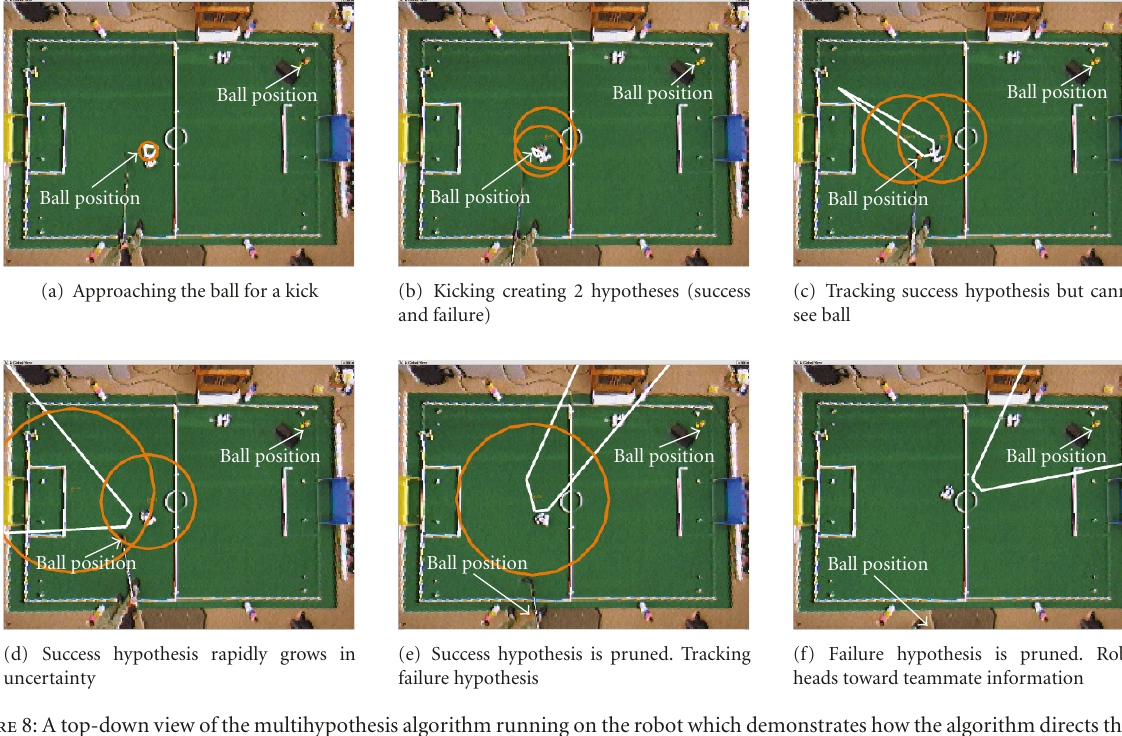
Figure 8: A top-down view of the multihypothesis algorithm running on the robot which demonstrates how the algorithm directs the robot’s actions. The field of view of the robot’s camera is shown with white lines while the circles represent the uncertainty in the tracked object position.